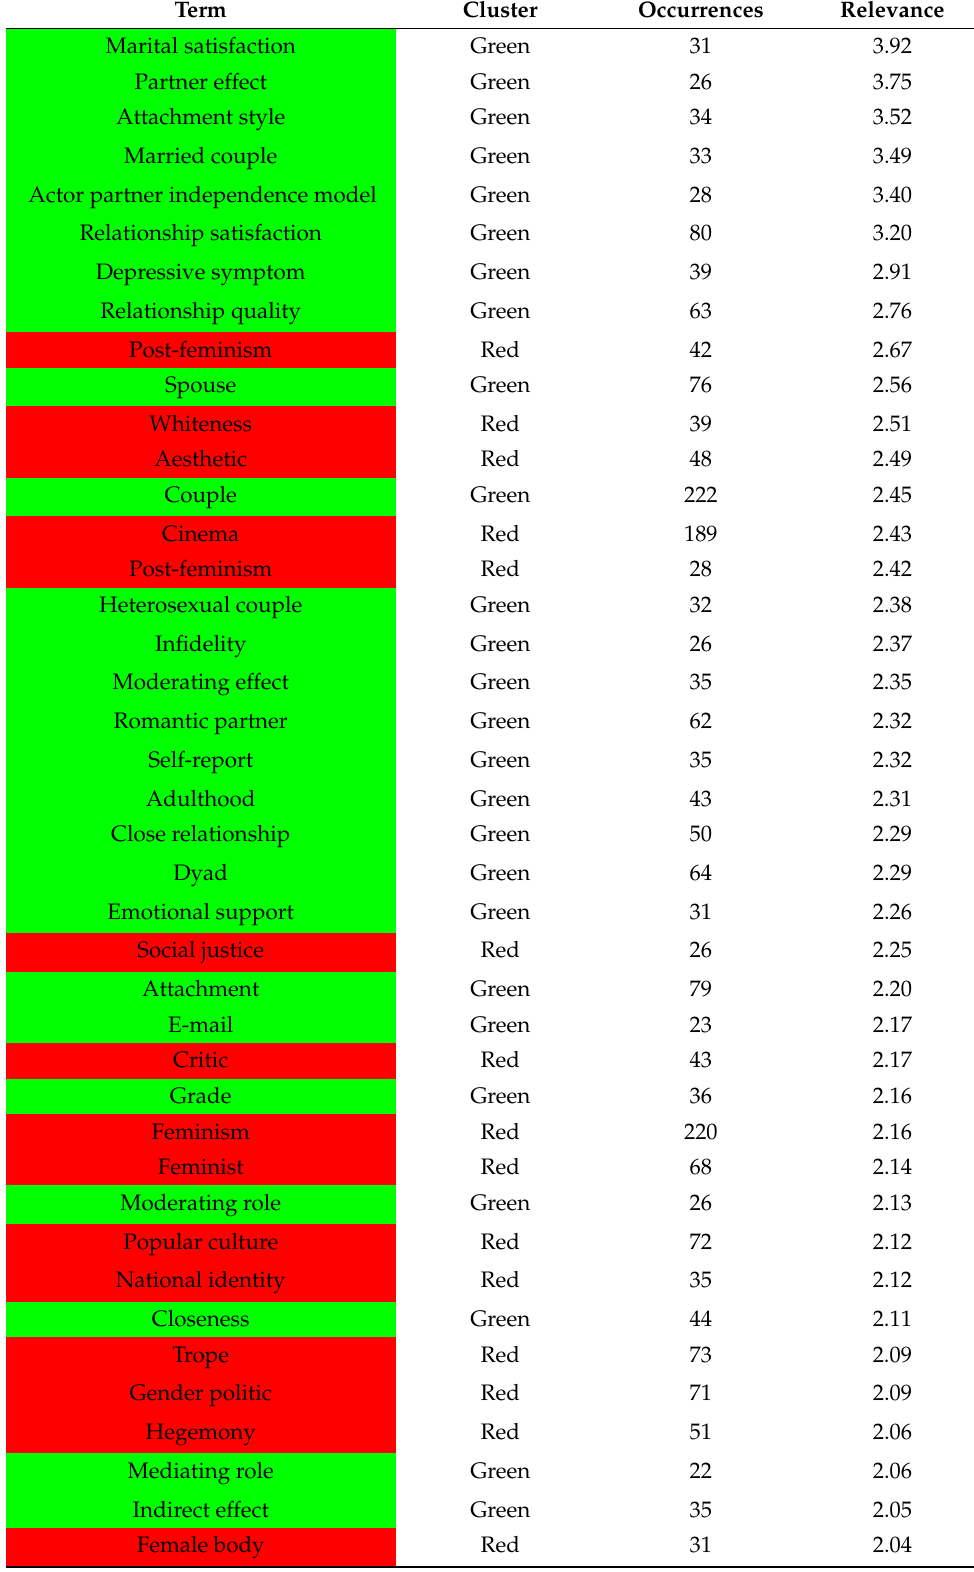
Table 8. Top 50 keywords according to